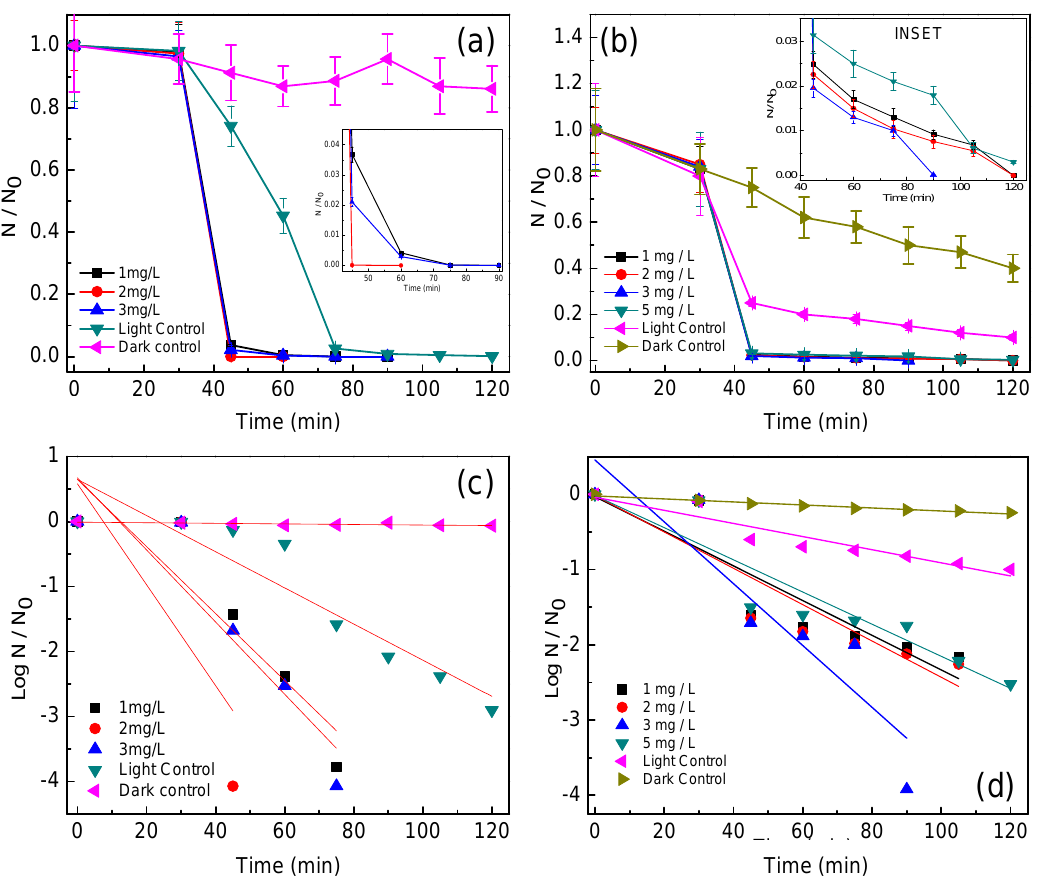
Figure 3. Effect of Ag@ZnO core ‐ shell NPs loading on the solar ‐ PCD kinetics of ( a ) E. coli and ( b ) S. aureus . Linear fitting plots of PCD kinetics of ( c ) E. coli and ( d ) S. aureus according to Chick ‐ Watson model. Initial bacteria concentration = 5 × 10 6 CFU/mL, Temperature = 35 ± 2 °C. Error bars indicate the standard deviation of replicates ( n = 3).